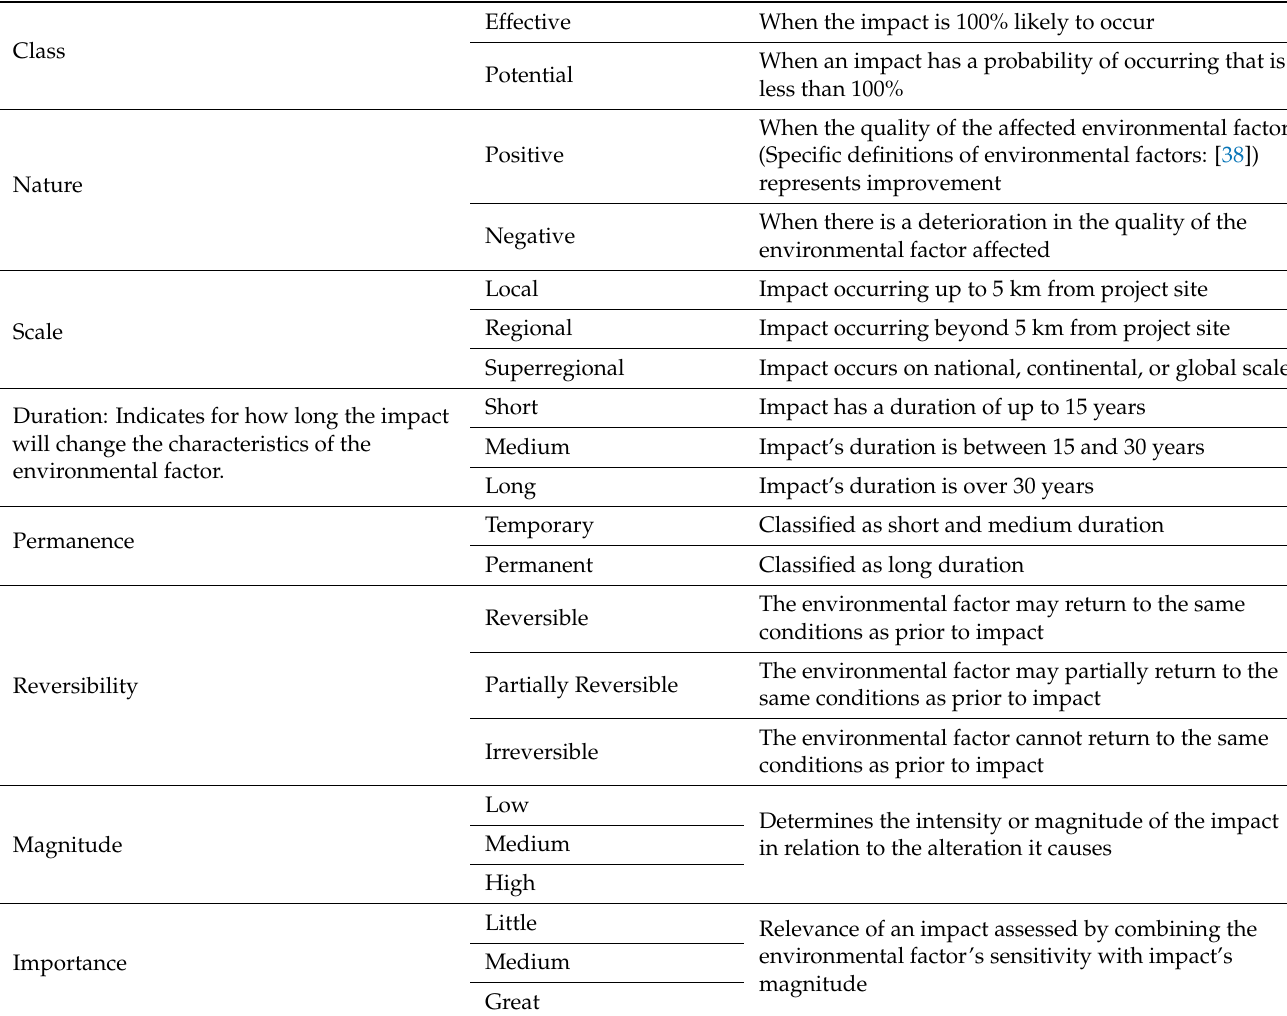
Table 1. The EIA/RIMA (Environmental Impact Study/Environmental Impact Report) definitions, quantifications, and qualifications used in this